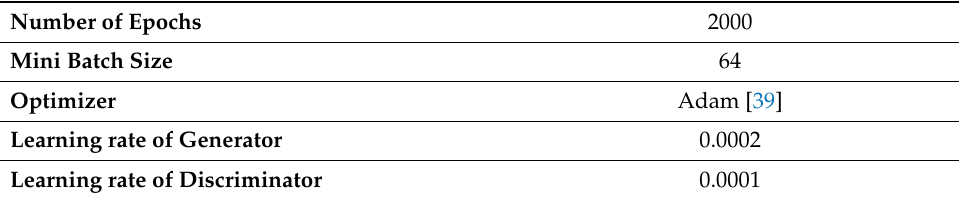
Table 2. Parameter configuration of the CGAN